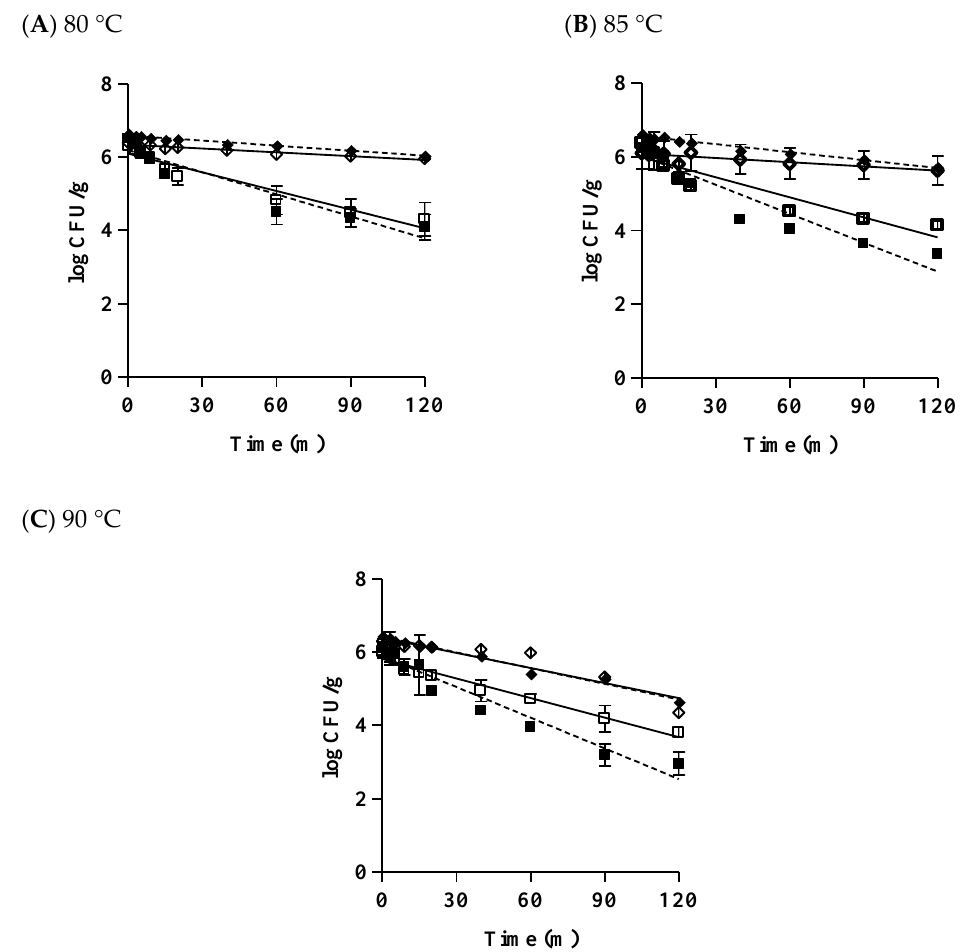
Figure 4. Time-dependent reduction in the B. cereus populations present in tofu heated at 80 °C ( A ), 85 °C ( B ), 90 °C ( C ). ■ Diarrheal vegetative cell; ◆ Diarrheal spore; □ Emetic vegetative cell; ◇ Emetic spore.